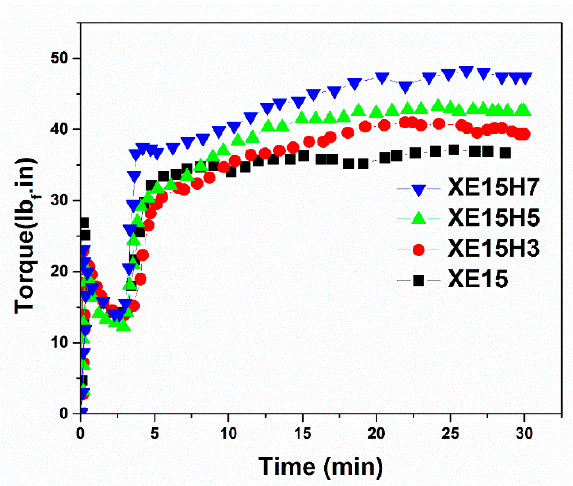
Figure 1. Cure behavior of XNBR/epoxy nanocomposites containing various XHNT loadings. Table 2. Cure parameters of XNBR/epoxy/XHNT nanocomposites at various heating rates.